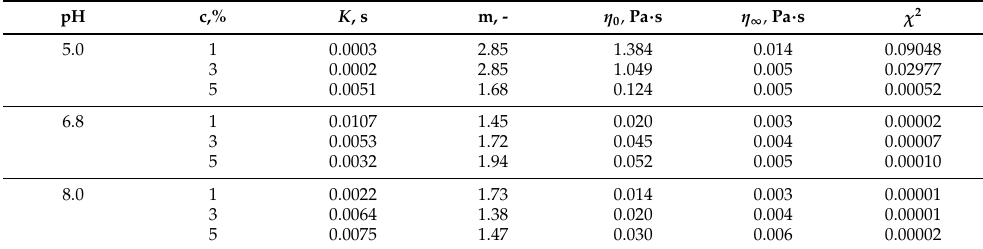
Table 3. The values of Cross model parameters.